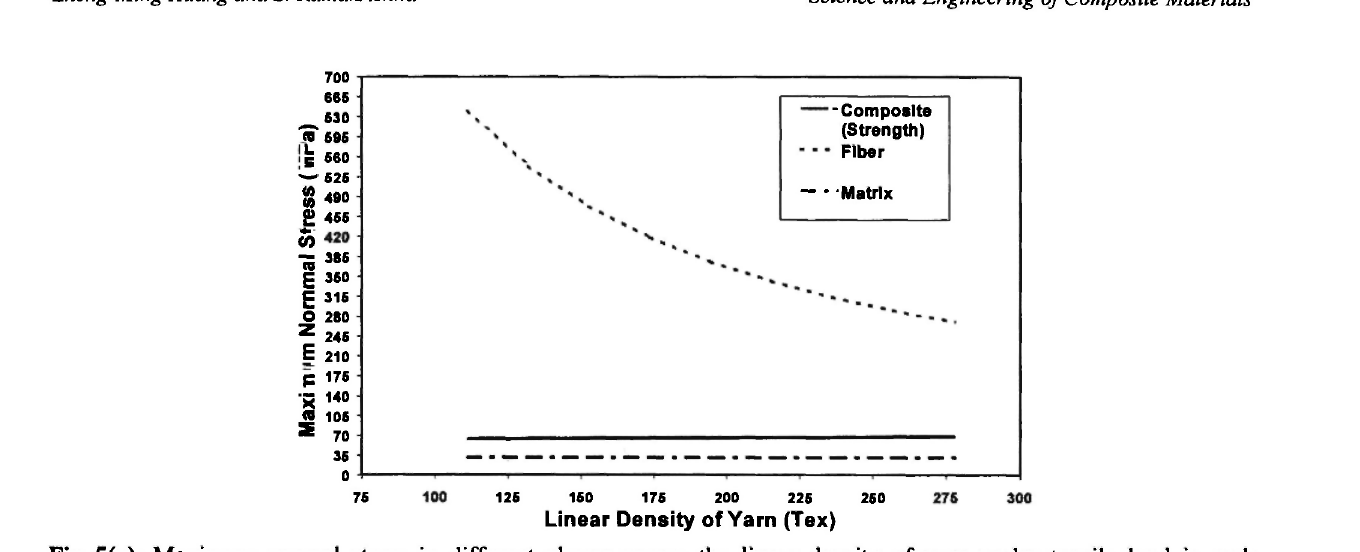
Fig. 5(a): Maximum normal stress in different phases versus the linear density of yarn under tensile load in wale direction. The geometric parameters used are: d= 0.0445cm, .£=0.45, p f =2.5g/cm 3 , C=2.5 loop/cm, W= 2 loop/cm and i=0.06cm.